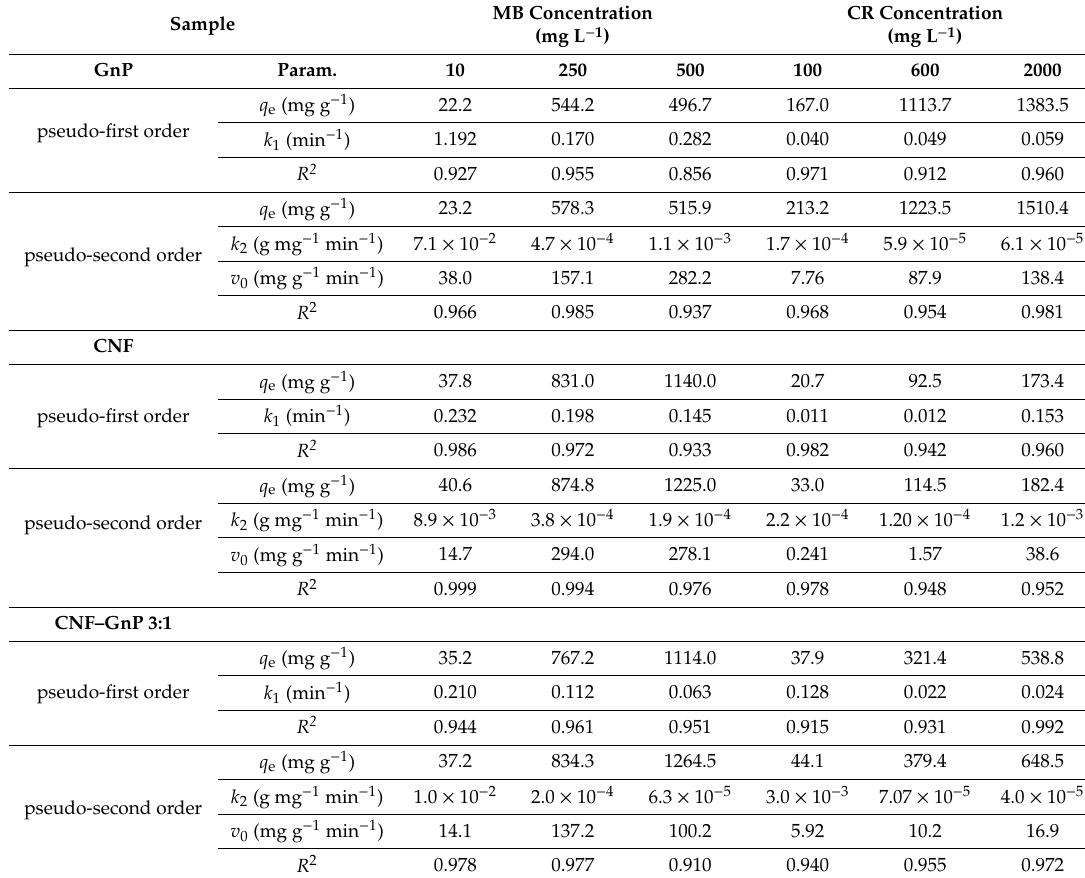
Table 1. Estimated kinetic parameters of the two adsorption models for methylene blue (MB) and Congo red